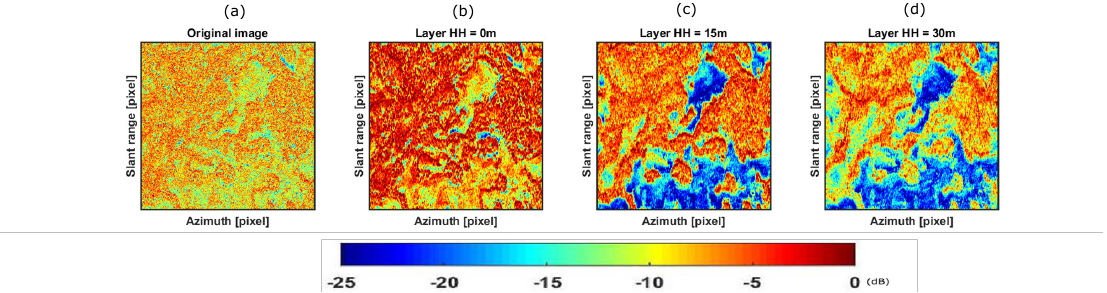
Figure 7. ( a ) Original SAR image. HH power intensities associated with a SAR image with three layers produced by TomoSAR: ( b ) 0 m, ( c ) 15 m, ( d ) 30 m.